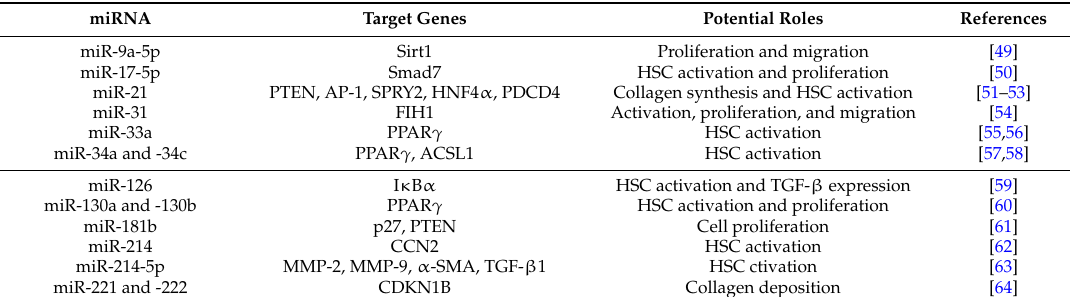
Table 2. Up-regulated miRNAs in activated hepatic stellate cells.